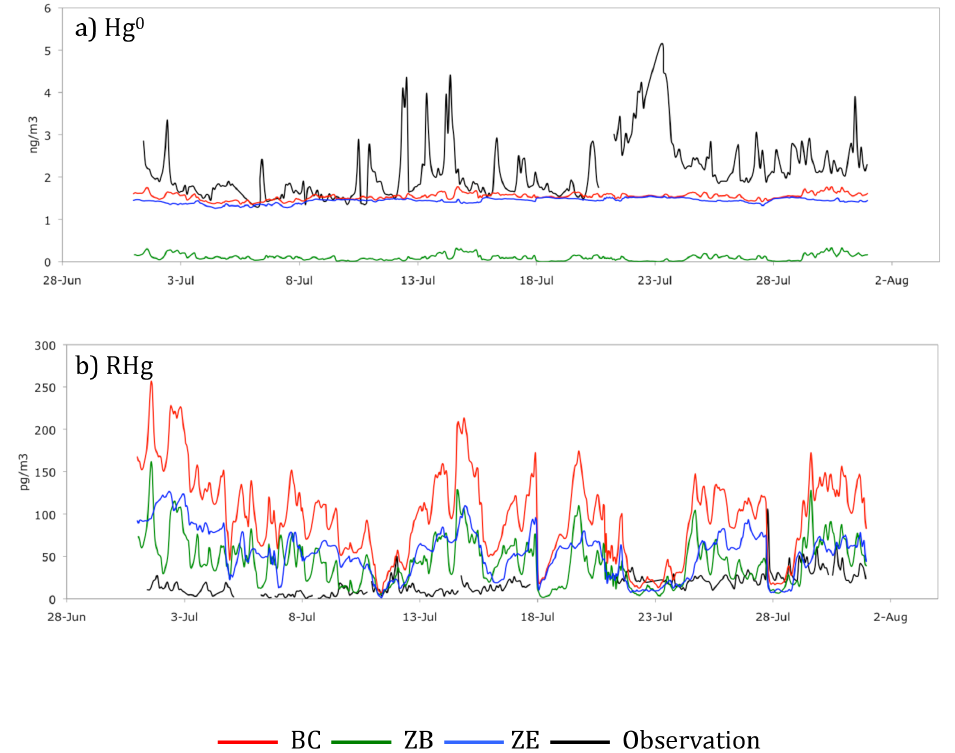
Fig. 6. Comparison of July 2003 CMAQ-Hg simulated ambient mercury species at MKE in the base case (BC), zero boundary inflow (ZB), and zero emissions (ZE) cases against July 2004 observed values for Hg 0 ( a , units ngm − 3 ) and RHg ( b , units pgm − 3 )